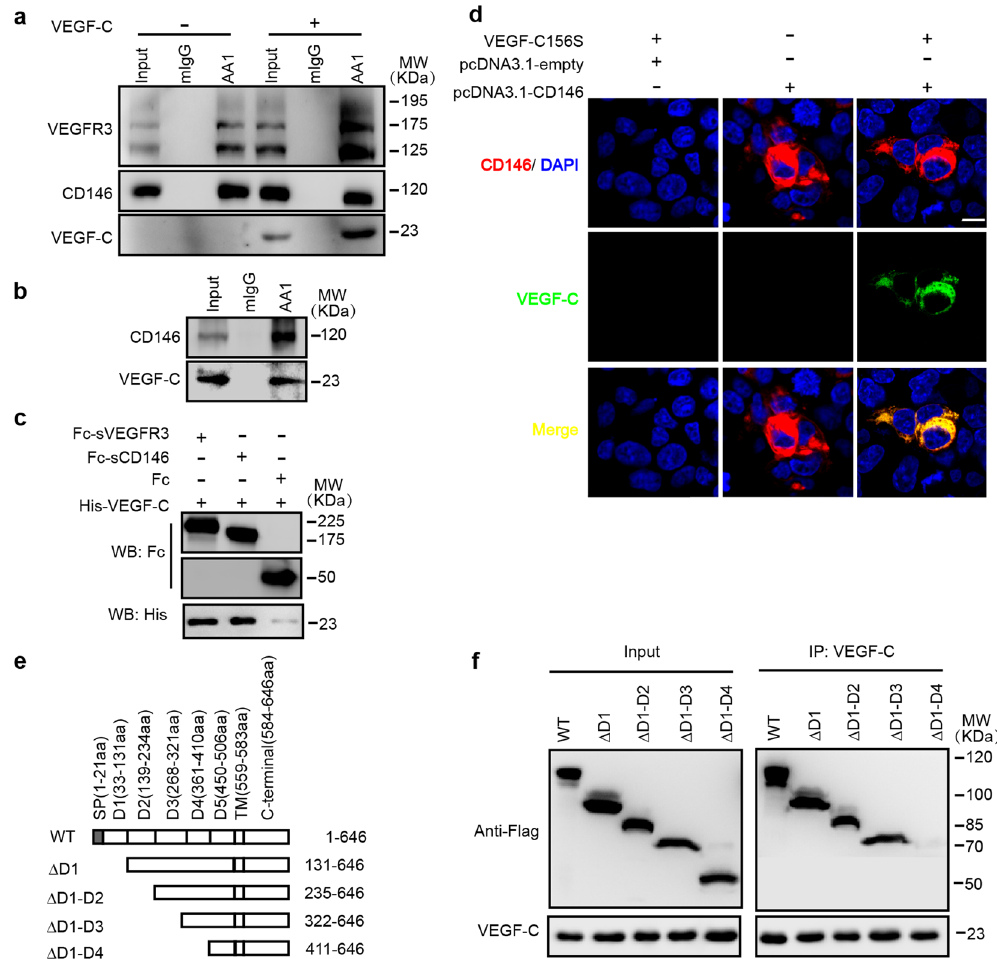
Figure 3. CD146 directly binds to VEGF-C. ( a ) Co-immunoprecipitation assays in HDLECs. Cells were incubated with normal culture medium or VEGF-C156S (100 ng/ml) conditional medium. The cell lysates were prepared for immunoprecipitation with control mIgG or anti-CD146 mAb AA1. ( b , d ) HEK293 cells transfected with control empty or CD146 expression vectors were incubated with VEGF-C conditional medium or transfected with CD146 encoding vector without VEGF-C incubation. Binding of VEGF-C-His to cells was detected by co-immunoprecipitation ( b ) and immunofluorescence ( d ). Scale bars: 100 μ m. ( c ) Direct in vitro interaction between VEGF-C and CD146 proteins. Purified Fc, Fc-CD146 or Fc-VEGFR-3 (200 ng/ml) was incubated with VEGF-C protein (200 ng/ml). The results were analyzed by WB. ( e , f ) defining the domain of CD146 required for interaction with VEGF-C. CD146 and its truncation mutants were expressed as Flag-tagged proteins. Immunoprecipitation was performed using anti-VEGF-C mAb. Full-length blots are presented in Supplementary Fig.